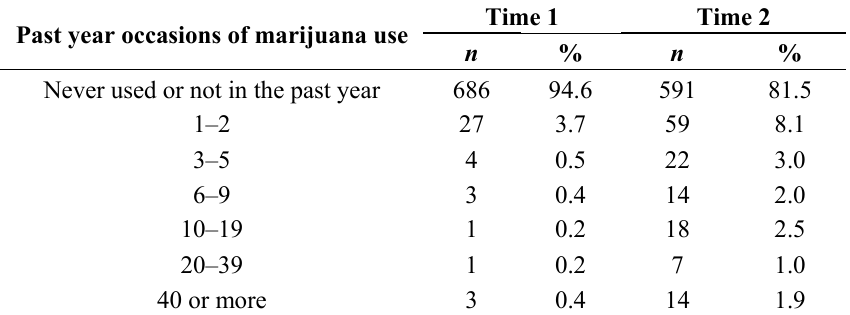
Table 2. Percent of adolescents by occasions of marijuana use in the past year at Times 1 and 2 ( N = 725).